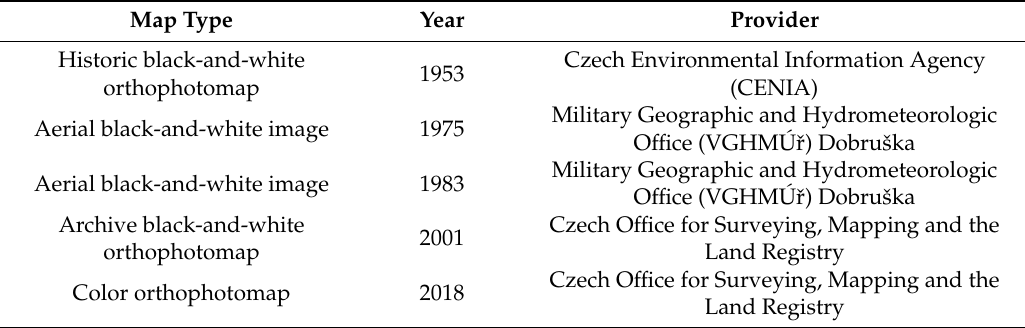
Table 3. Map documents used for land cover